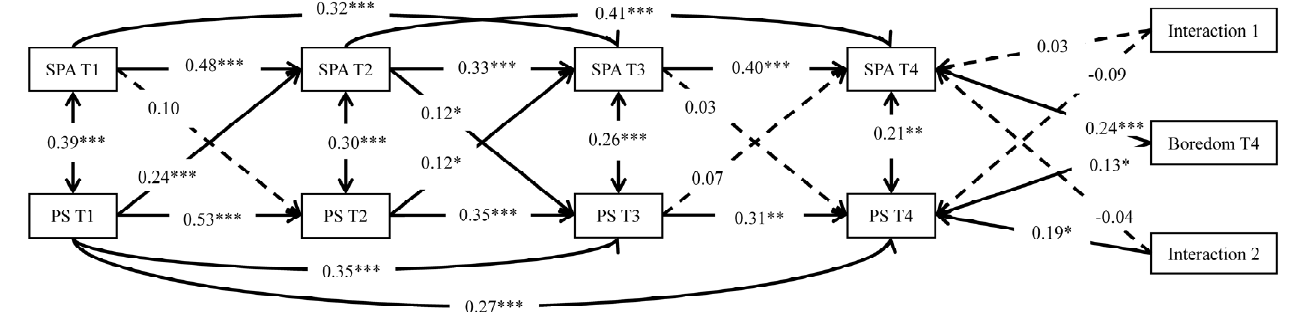
Figure 2. The moderated cross-lagged model of smartphone addiction (SPA), perceived stress (PS), and boredom (N = 197). Note: Interaction 1 = Boredom at T4 × SPA at T3; Interaction 2 = Boredom at T4 × PS at T3.